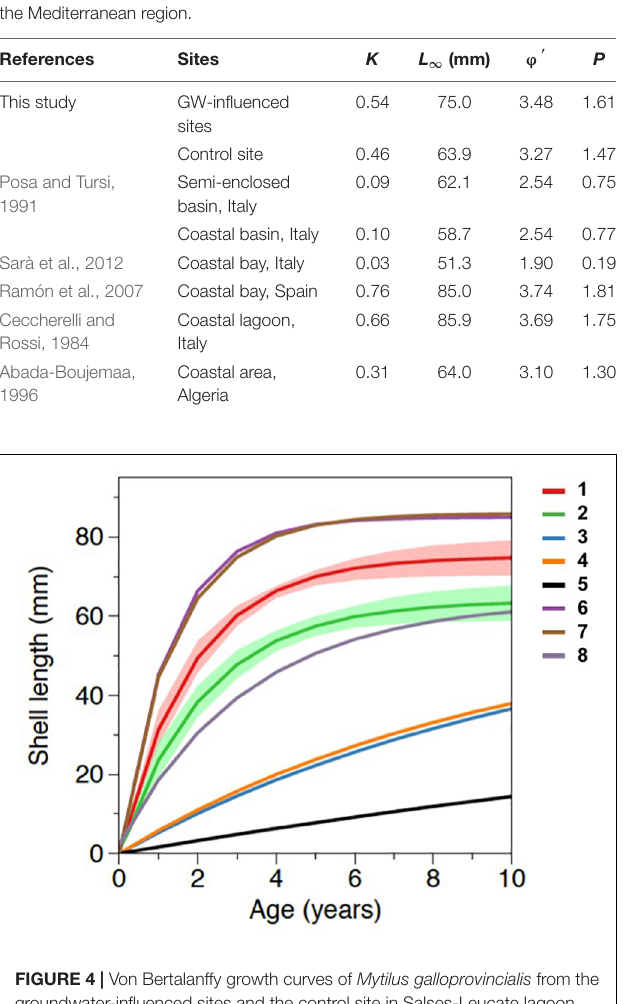
FIGURE 4 | Von Bertalanffy growth curves of Mytilus galloprovincialis from the groundwater-influenced sites and the control site in Salses-Leucate lagoon and from other coastal systems in the Mediterranean region with 1 : groundwater-influenced sites in this study ( K = 0.54, L ∞ = 75.0); 2 : control site in this study ( K = 0.46, L ∞ = 63.9); 3 : semi-enclosed basin in Italy ( K = 0.09, L ∞ = 62.1, Posa and Tursi, 1991); 4 : coastal basin in Italy ( K = 0.10, L ∞ = 58.7, Posa and Tursi, 1991); 5 : coastal bay in Italy ( K = 0.03, L ∞ = 51.3, Sarà et al., 2012); 6 : coastal bay in Spain ( K = 0.76, L ∞ = 85.0, Ramón et al., 2007), 7 : coastal lagoon in Italy ( K = 0.66, L ∞ = 85.9, Ceccherelli and Rossi, 1984), and 8 : coastal area in Algeria ( K = 0.31, L ∞ = 64.0, Abada-Boujemaa, 1996). Shaded areas represent the standard deviations of data obtained in the present